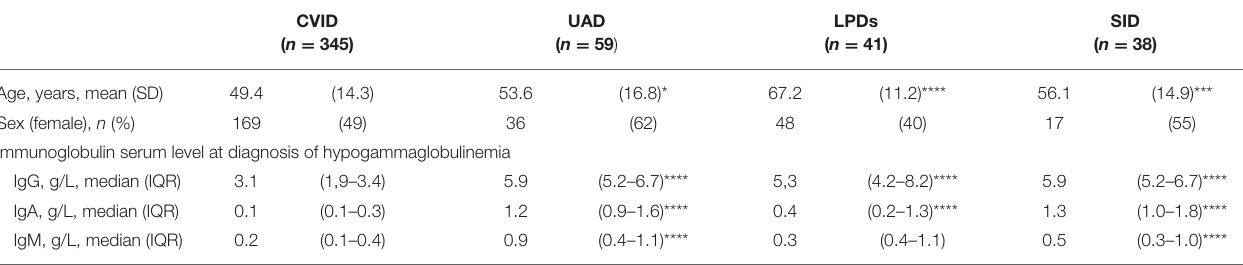
TABLE 1 | Demographics and immunoglobulin serum levels at diagnosis in the cohort included in the analysis.